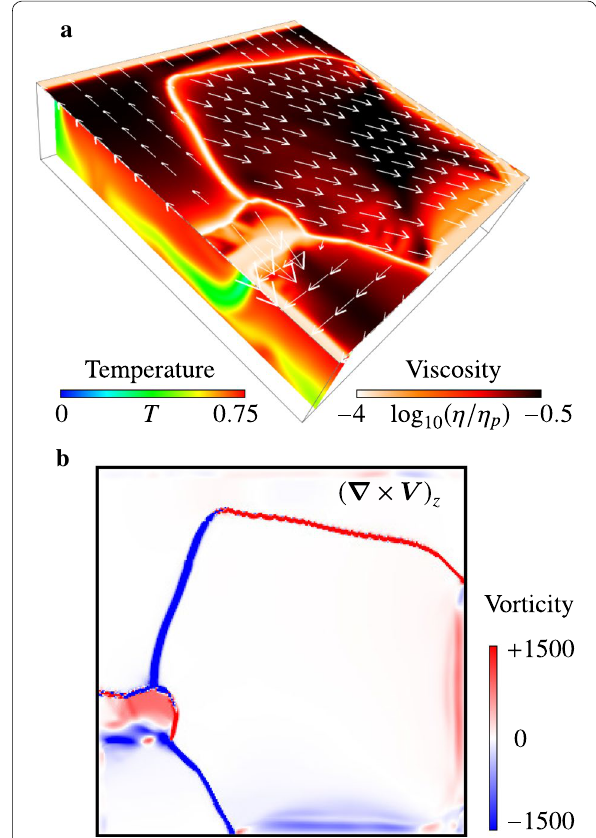
Fig. 1 The overall three-dimensional structure of thermal convection obtained in our numerical model with stress-history-dependent rheology. a The distribution of temperature T in a vertical cross section and that of viscosity η (colour) and velocity V (arrows) on the surface. The value of η is normalised by η p , the viscosity of intact material at the surface. b The distribution of the vertical component of vorticity ( ∇ × V ) z on the